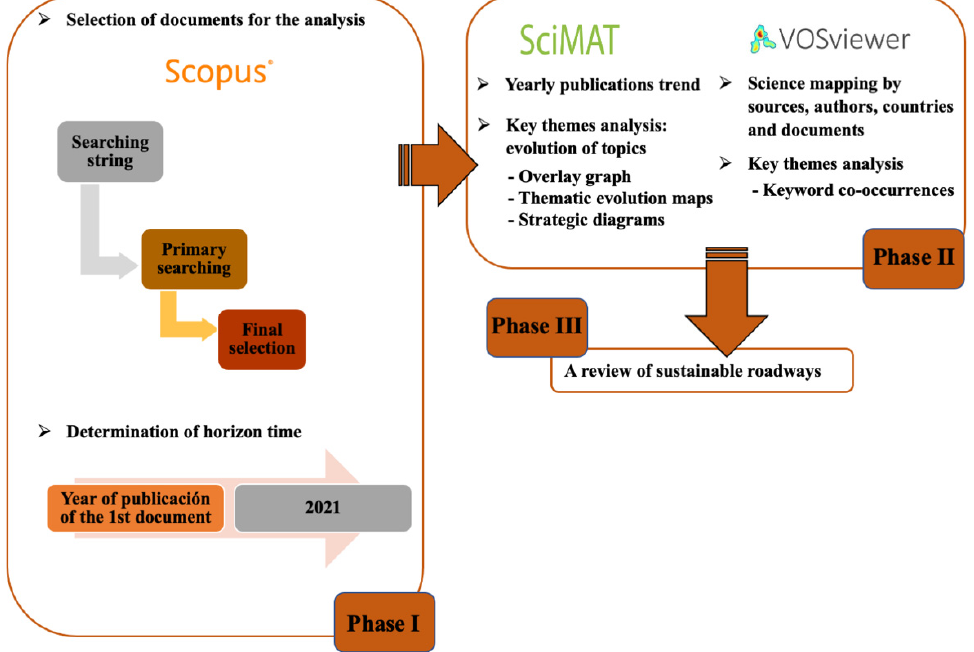
Figure 1. Applied methodology description.